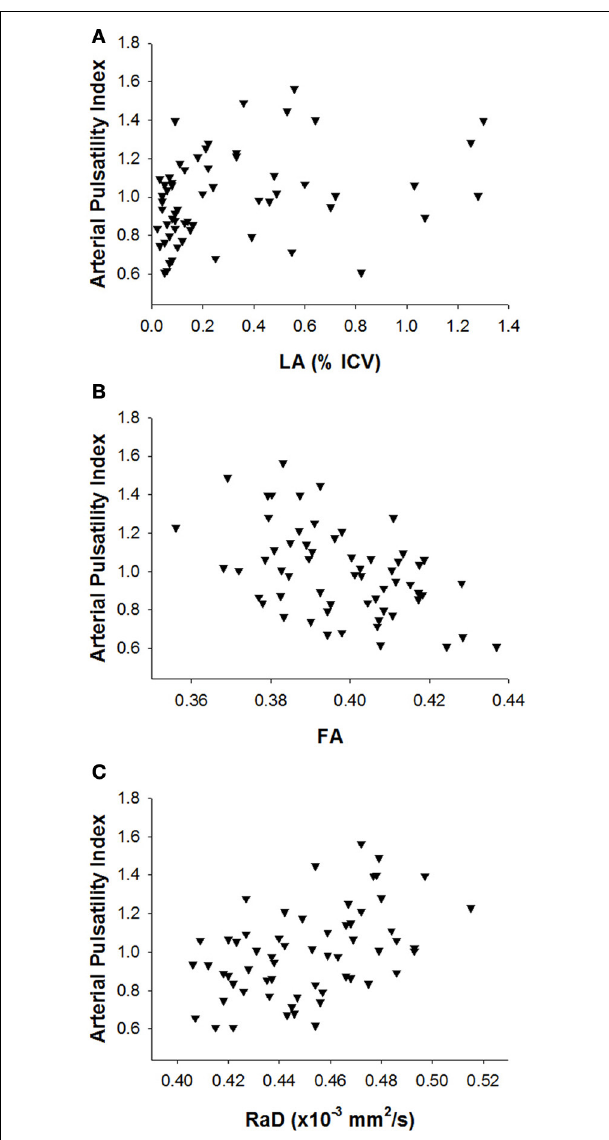
FIGURE 1 | Scatterplots of the relationship between arterial pulsatility index and (A) leukoaraiosis severity, (B) fractional anisotropy, and (C) radial diffusivity.